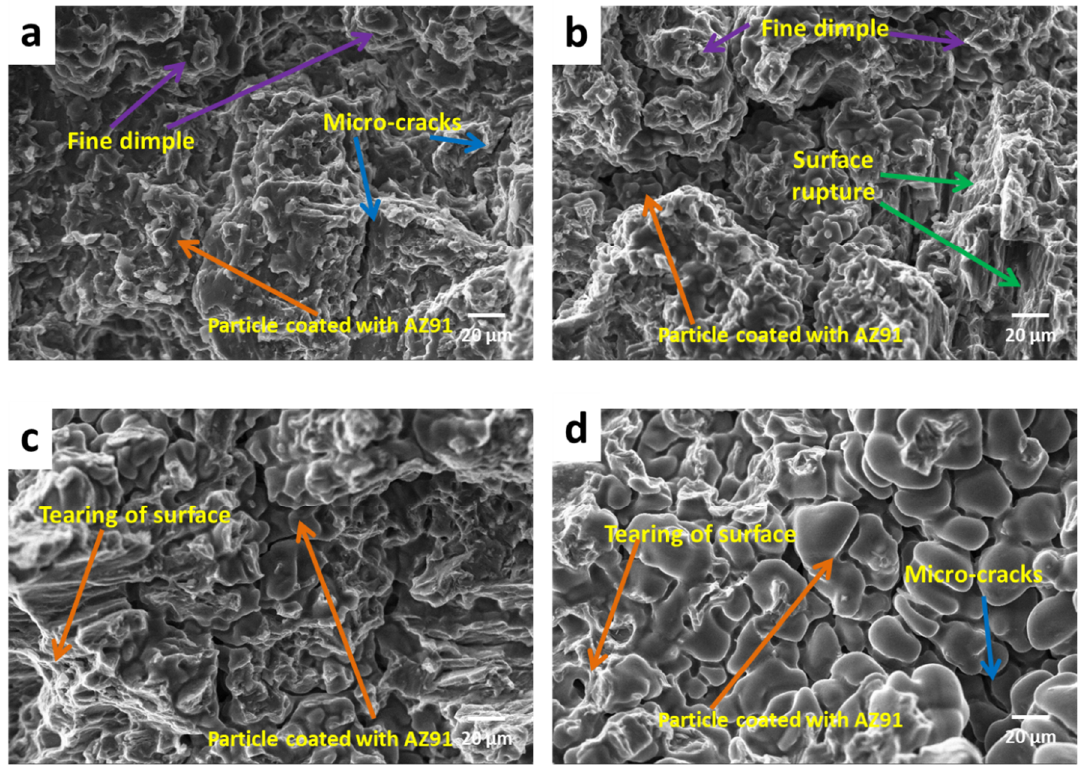
Figure 9. SEM tensile fractograph of cast magnesium alloy AZ91-based composites: ( a ) 2% SiC, ( b ) 5% SiC, ( c ) 8% SiC, ( d ) 11% SiC.